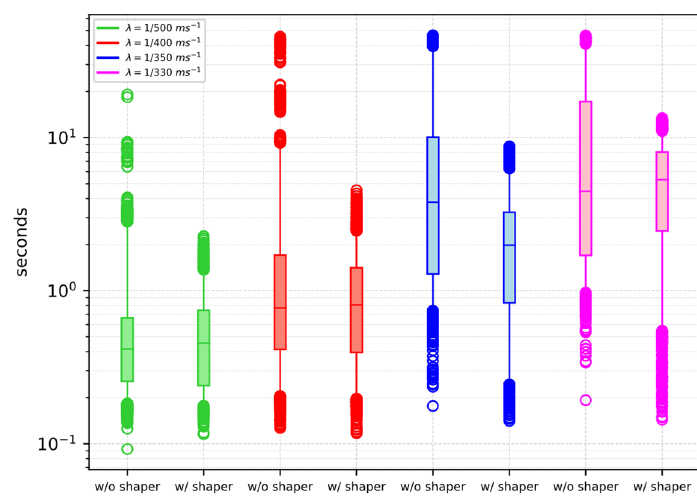
Figure 7. Service delay box plot w/ and w/o the request